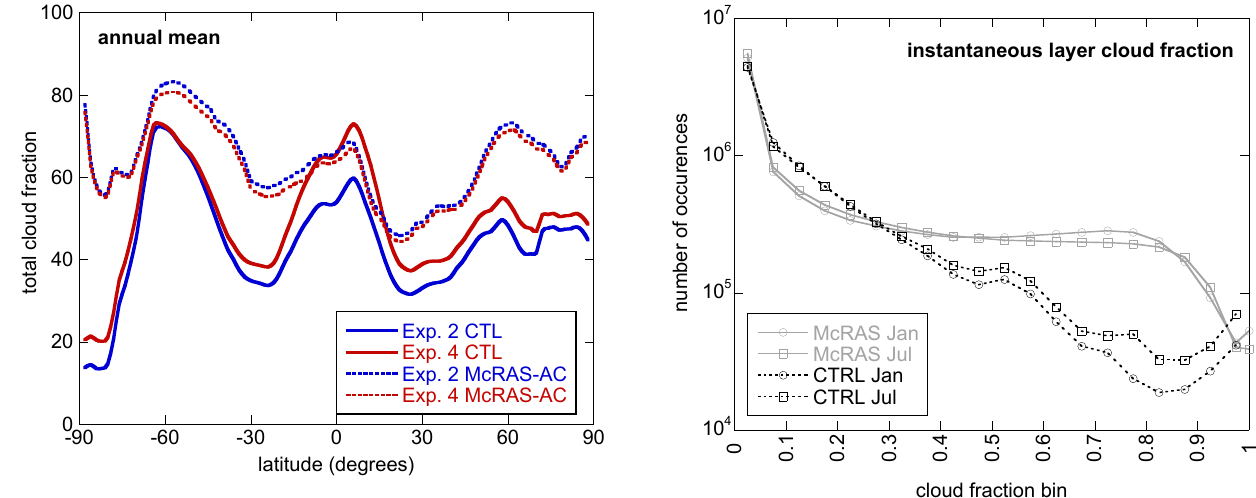
Fig. 11. Frequency distributions of twice-daily sampled instanta- neous layer cloud fraction during January and July within the period of our runs. The cloud fraction bins are 0.05 wide, with a separate bin for completely overcast conditions. The first bin does not in- clude clear